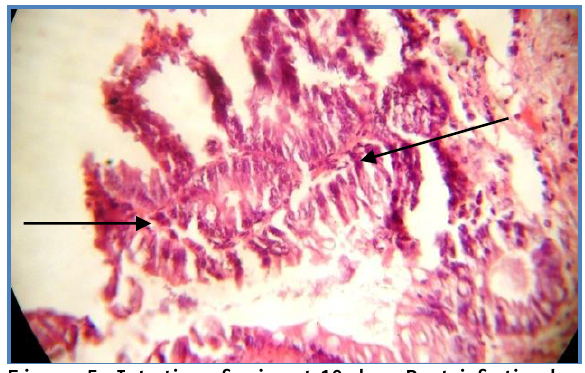
Figure, 5: Intestine of mice at 10 days Post infection by Candida albicans ( ) shows necrosis of intestinal gland and villi. (Heamatoxcyline and Eosin stain